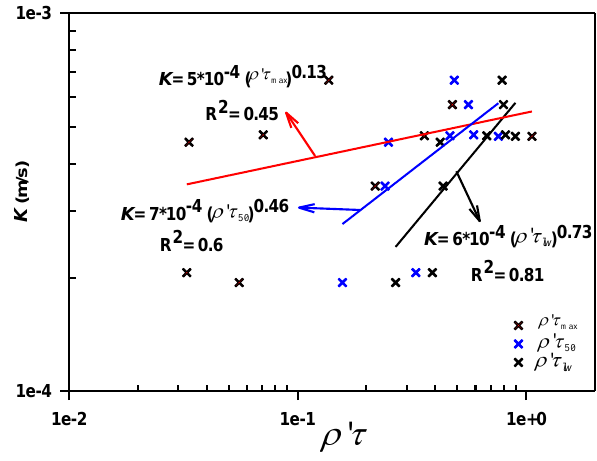
Fig. 14. Log-log plot of the maximum relaxation time ( max ), median relaxation time ( 50 ) and 311 Fig. 14. Log–log plot of τ max , τ 50 and τ lw multiplied by ρ 0 against weighted average relaxation time ( lw ) multiplied by ρ ʹ against the measured hydraulic 312 the measured K of nine core samples from the first aquifer (see conductivity ( K ) of nine core samples from the 1 st aquifer (see Fig. 1). 313 Fig. 314